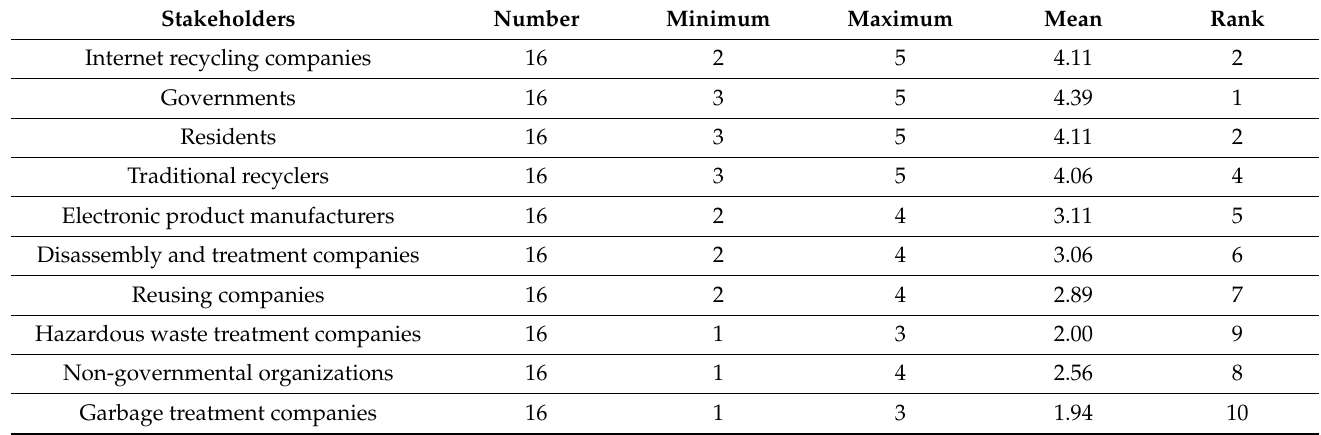
Table 6. WEEE internet recycling industry stakeholder urgency scores.